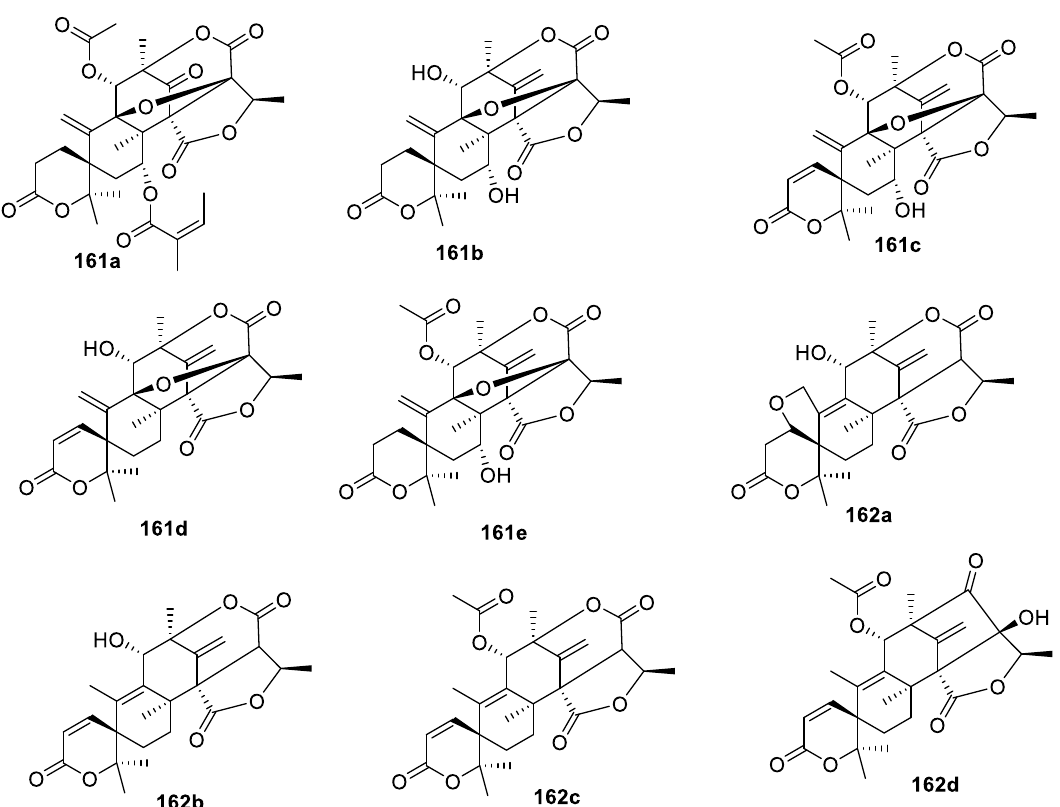
Figure 75. Bioactive [5.5.0] spirocyclic meroterpenoids isolated from mangrove-derived fungus Penicillium sp.